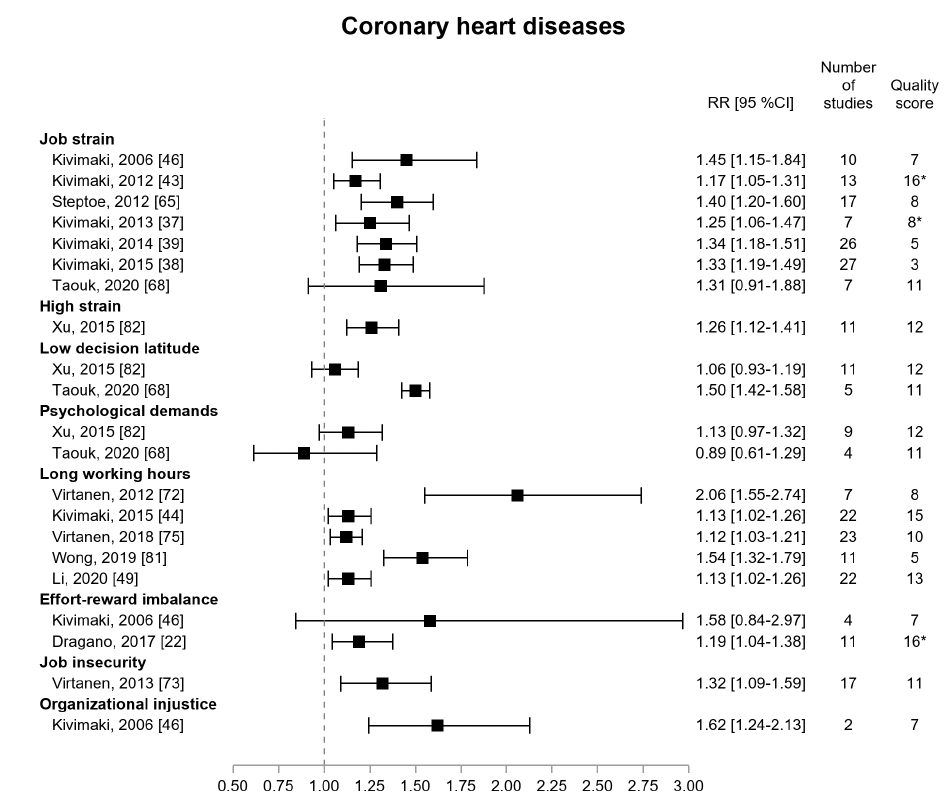
Figure 2. Pooled estimates for the associations between psychosocial work exposures and coronary heart diseases. * IPD-Work Consortium studies without systematic literature review.